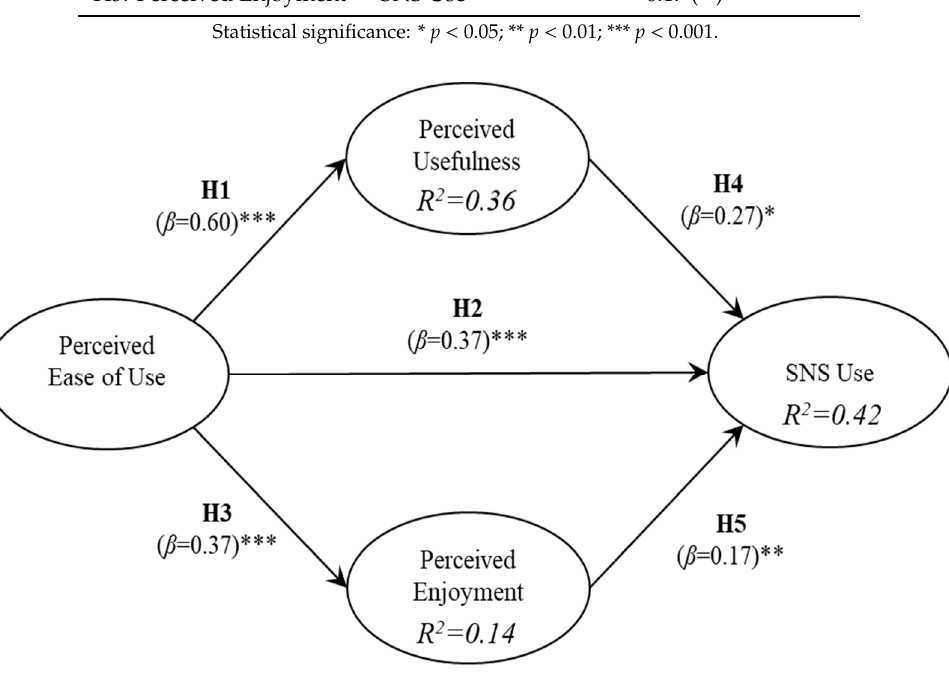
Figure 2. Model for older adults—users of social network systems (SNS). Statistical significance: * p < 0.05; ** p < 0.01; *** p < 0.001. Table 4. Relationship by β coefficients.